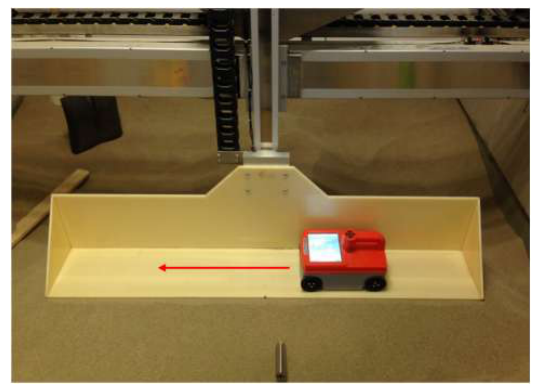
Figure 2. Schematic illustration of the measurement process using the developed GPR-EMI dual sensor and an example of measured EMI and GPR data.